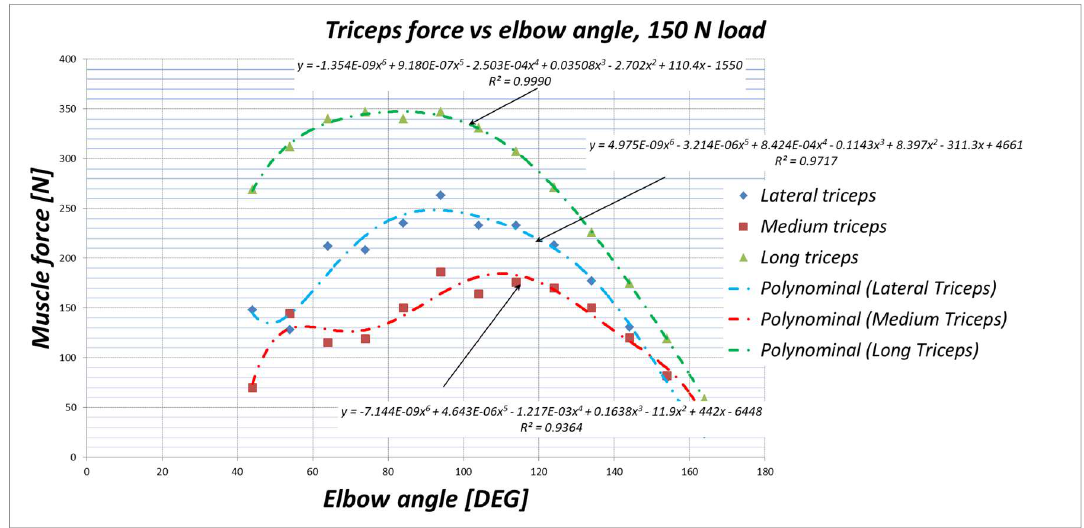
Figure 14. Comparison of the (continuous line) calculated and (dash point line) comparison, for triceps forces (Y-axis). Isometric contractions on the elbow at different positions, from 44 to 164 degrees (X-axis) and 150 N are loaded on the wrist.